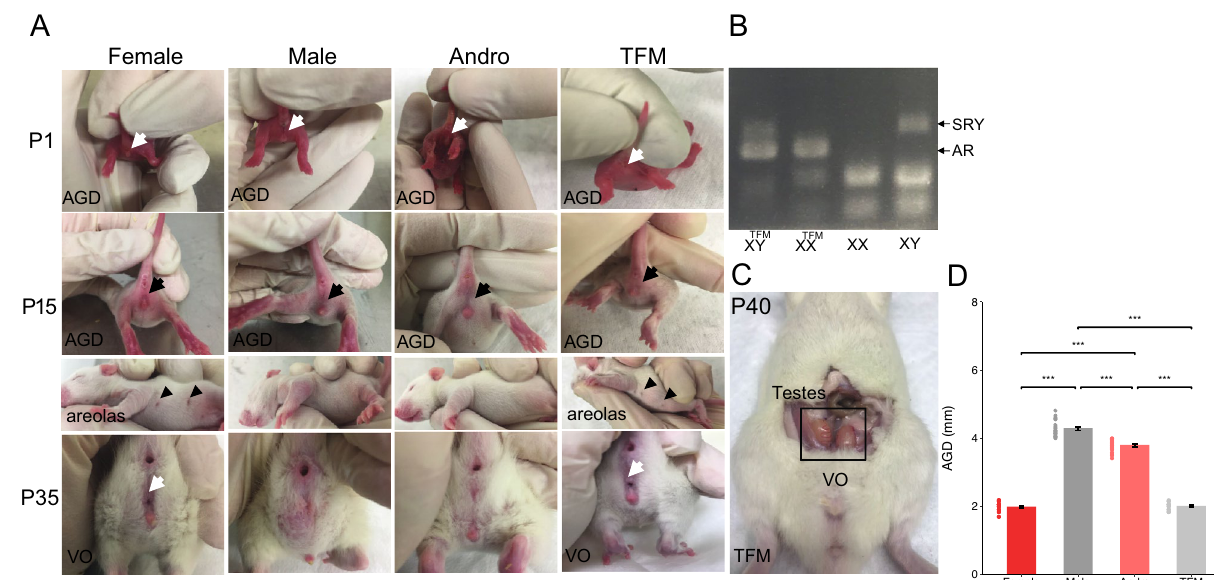
Figure 2. Testosterone levels affect sexual developmental markers. ( A ) Photographs show representative anogenital distances AGD (white arrows) observed in male, female, testosterone-treated females, and testosterone-insensitive male rats at P1, 15 and 35. Presence or absence of areolas are represented by black arrowheads. Vaginal opening (VO) is observed (white arrows) at P35. ( B ) PCR confirming the genotype of each animal (Tfm vs. wt alleles for androgen receptor (AR). ( C ) Presence of testes in testosterone-insensitive males despite the feminine external phenotype. ( D ) Bar graph shows significant differences in AGD length between sex groups (F: 1.98 ± 0.03 mm, n = 24 rats from 5 litters; M: 4.27 ± 0.05 mm, n = 25 rats from 5 litters; A: 3.79 ± 0.04 mm, n = 23 rats from 7 litters; TFM: 2.00 ± 0.03 mm, n = 17 rats from 6 litters; One-way ANOVA with Tukey’s post hoc analysis, F × M, F × A TFM × M, TFM × A: p < 0.0001). Dots represent individual data points. F females, M males, A andro/testosterone-treated females, TFM testosterone-insensitive males. Graphs represent mean ±